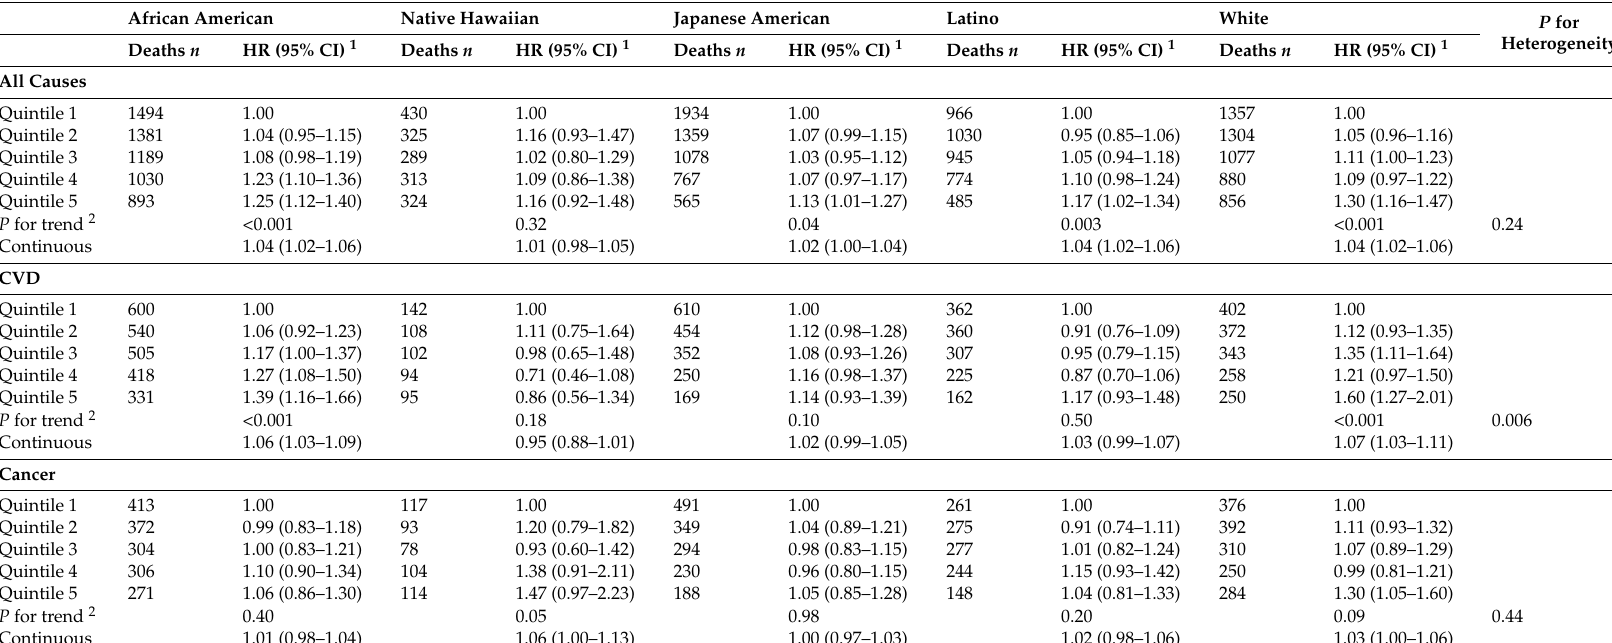
Table 4. Hazard ratios (HR) (95% confidence intervals (CI)) for all-causes, cardiovascular disease (CVD), and cancer mortality according to quintiles of Dietary Inflammatory Index scores by race/ethnicity among women in the Multiethnic Cohort,